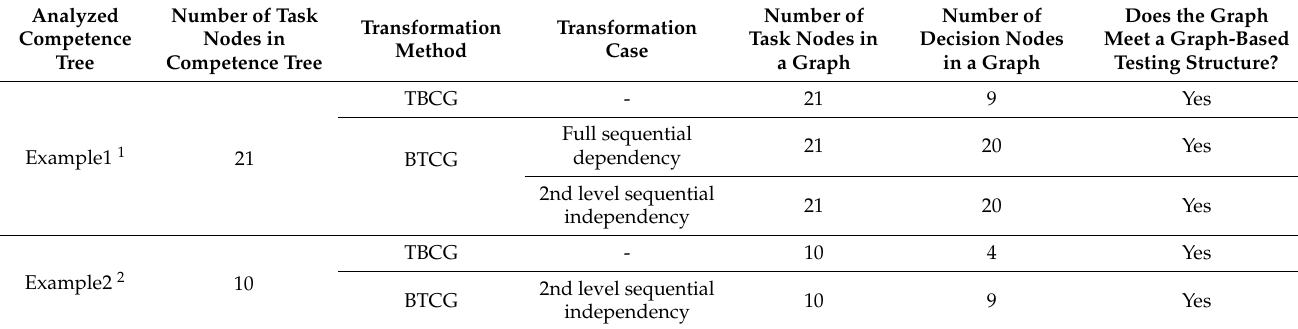
Table 1. Result summary of the proposed competence tree transformation to graph-based structure.